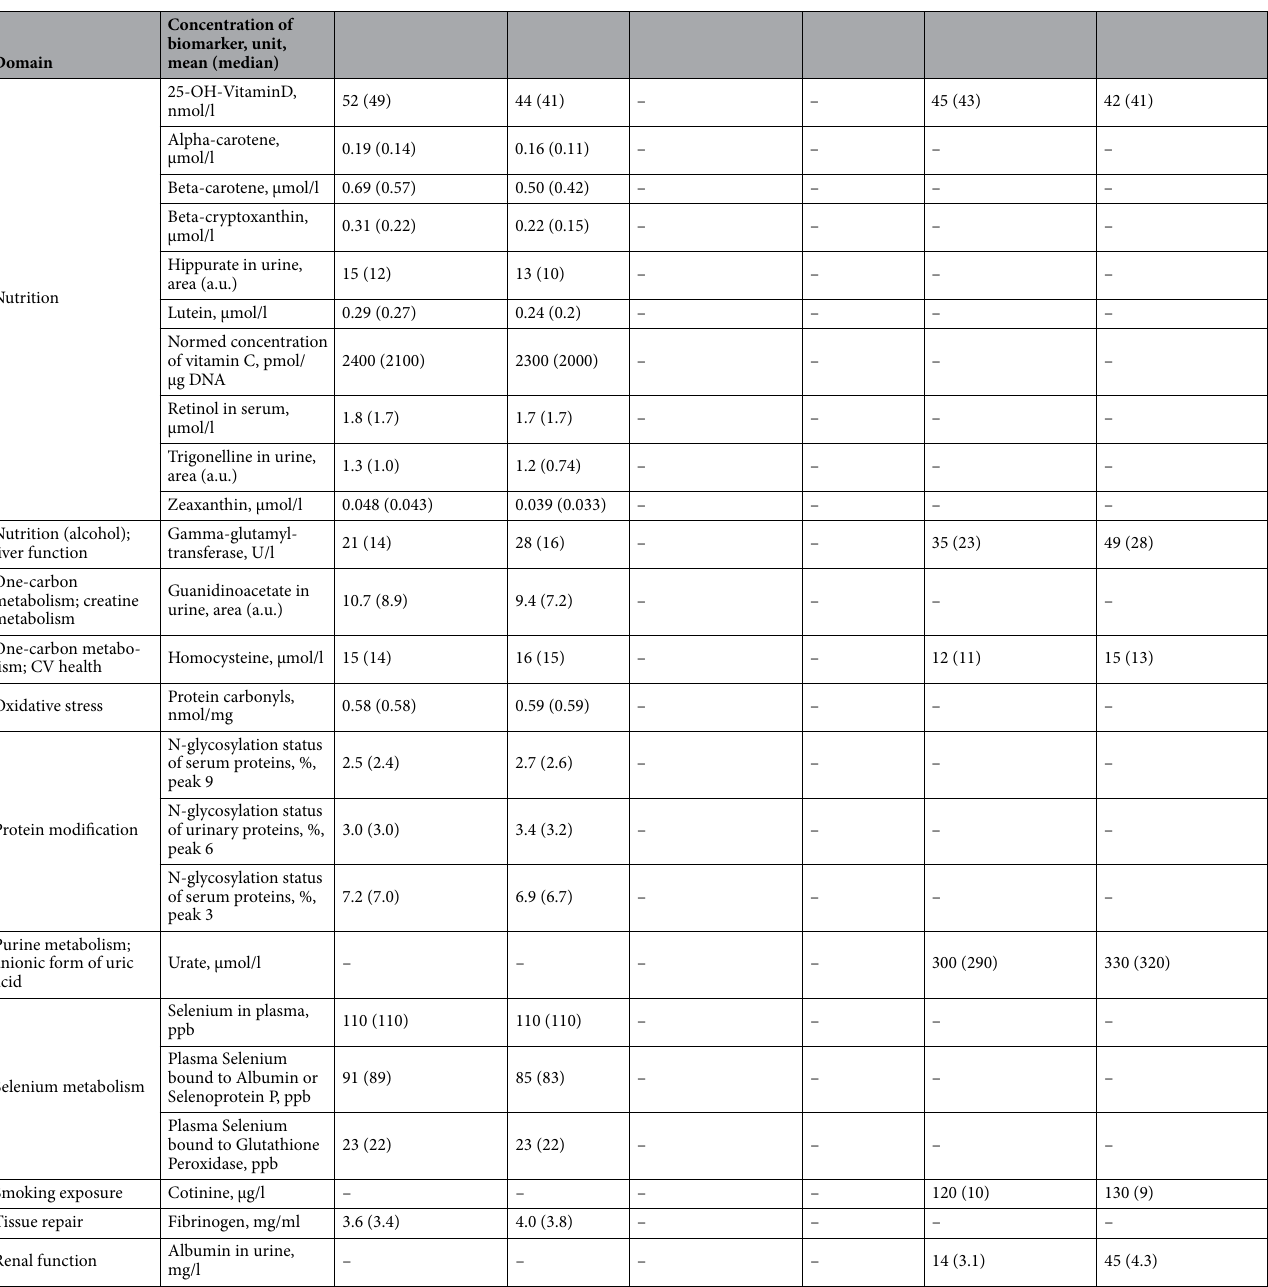
Table 1. Participant characteristics by SRH. The 57 biomarkers presented in the table were all associated with SRH in linear modelling when adjusted for age and gender (model i). a.u. arbitrary